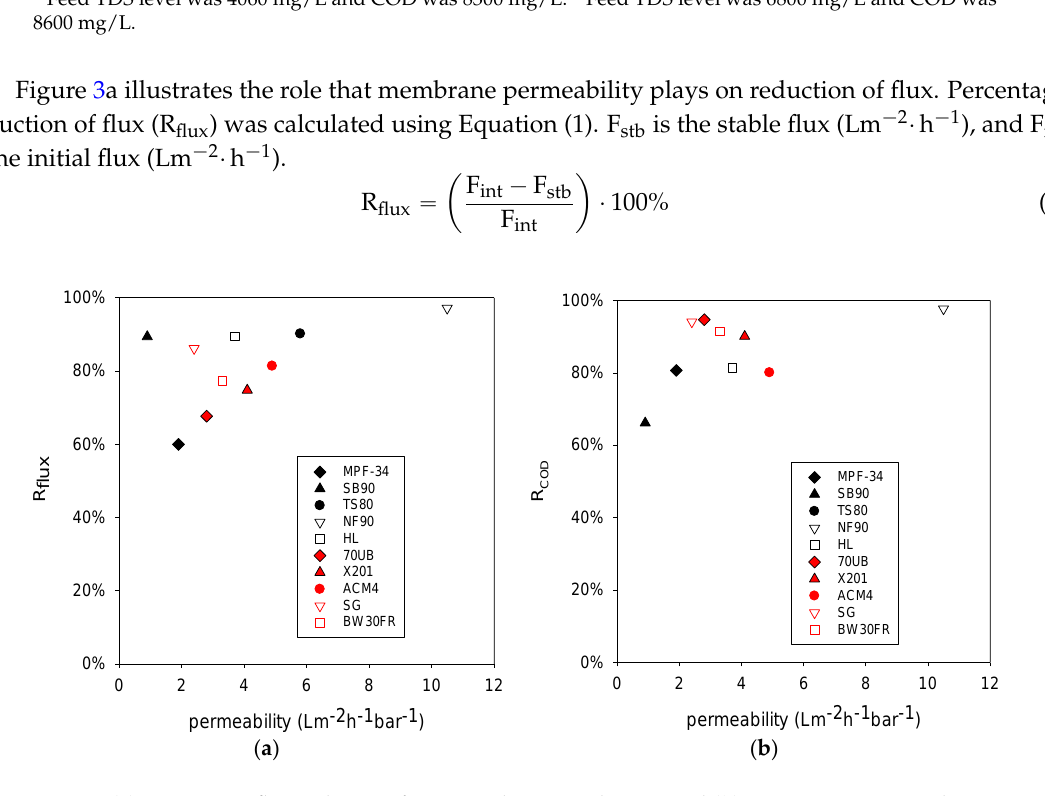
Figure 3. ( a ) Percentage flux reduction for RO and NF membranes and ( b ) percentage COD reduction. Figure 3a shows that R flux does not correlate strongly with the membrane permeability. R flux is associated with membrane fouling. The most permeable membrane NF90 did have the highest R flux , indicating that this membrane was more severely fouled than other membranes. However, in general membrane type ( i.e. , NF or RO) does not seem to play a significant role here. Figure 3b compares percentage COD reduction to membrane permeability. COD reduction is defined in Equation 2. RO membranes (red symbols) had higher R COD than NF membranes (black symbols) with similar permeability. As mentioned earlier, RO membranes have lower MWCO [4,5], which may be able to sieve larger organic molecules than the NF membranes, leading to higher R COD . The most severely fouled membrane NF90 had a high R COD compared to other NF membranes. This finding may be associated with the foulant layer on the membrane surface. While this layer increased the transport resistance, it also improved the sieving capability and increased COD reduction.